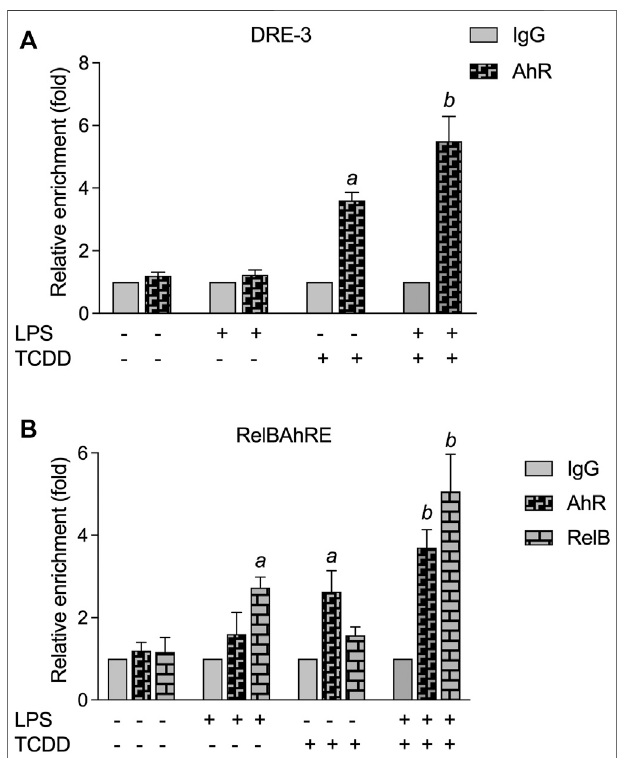
FIGURE7| ChIPassayforDRE-3andtheRelBAhREregionsofthemIL- 22 promoter. (A) TCDD and LPS stimulate therecruitmentofAhRtothe DRE- 3 site and (B) the RelBAhRE site of the mIL-22 promoter. BMM from three mice were stimulated with TCDD in the presence or absence of LPS for